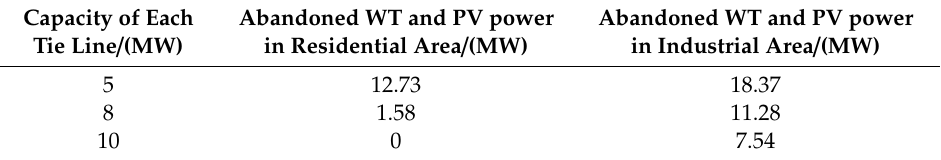
Table 7. Abandoned WT and PV power in functional areas under di ff erent tie line capacities.